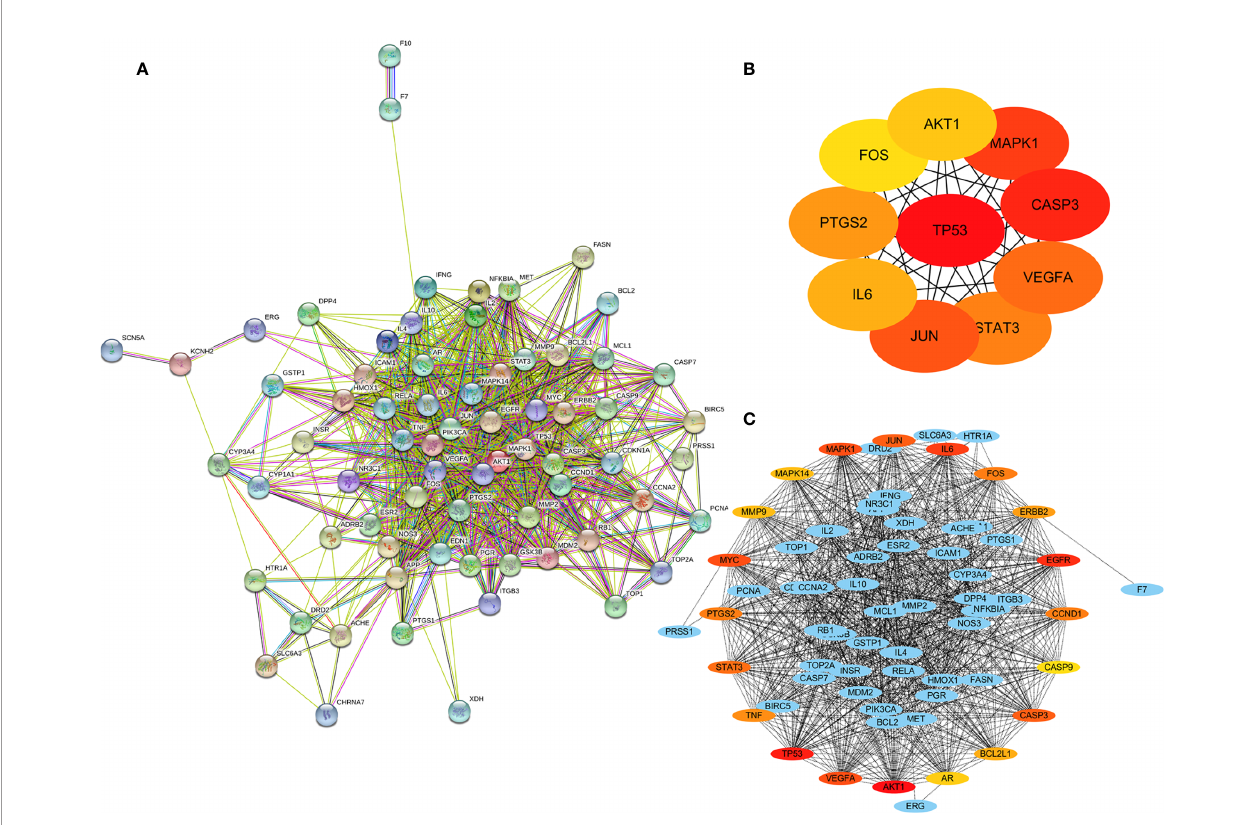
FIGURE 4 | Protein-protein interaction (PPI) network of 70 common genes. (A) PPI network of common genes, (B) Top 10 hub genes of 70 common genes by MCC algorithm. (C) Top 20 hub genes of 70 common genes with expanded